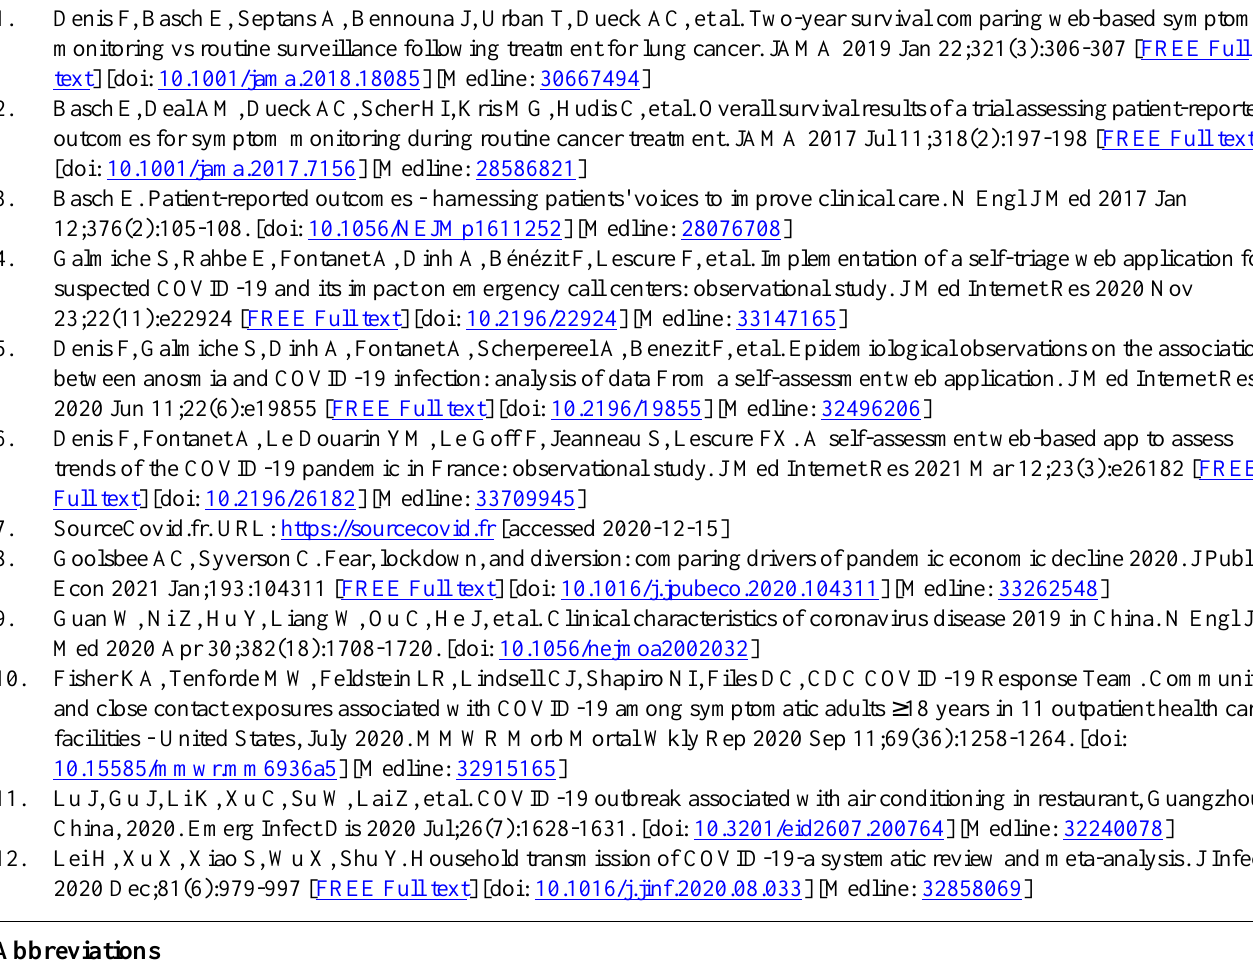
RT-PCR: reverse transcription polymerase chain